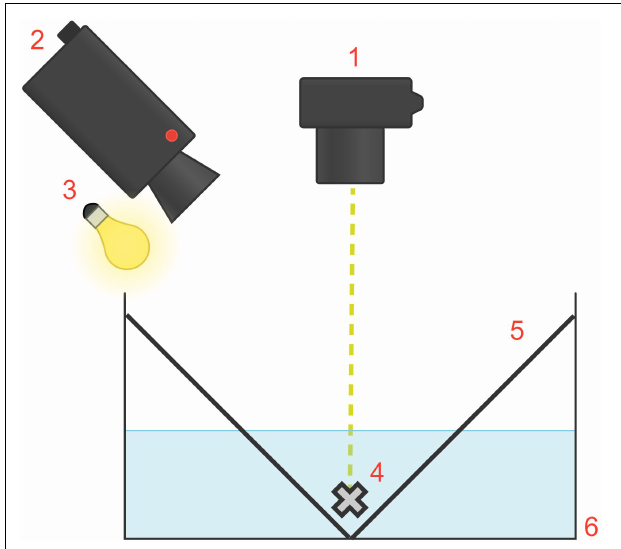
FIGURE 2 | Diagram of the experimental tank set-up, measuring 53 cm × 43 cm × 18 cm (situated inside the rig; external rig structure and black tarp and opaque covers not shown). The flash unit (1) providing the visual startle stimulus was fixed on the rig at a right angle and 50 cm above the animal (4). The camera (2) and light source (3) were at a 45 ◦ angle above the animal. The white “V-shaped” partition configuration (5) enabled squid to settle naturally at the bottom of the white, rectangular tank